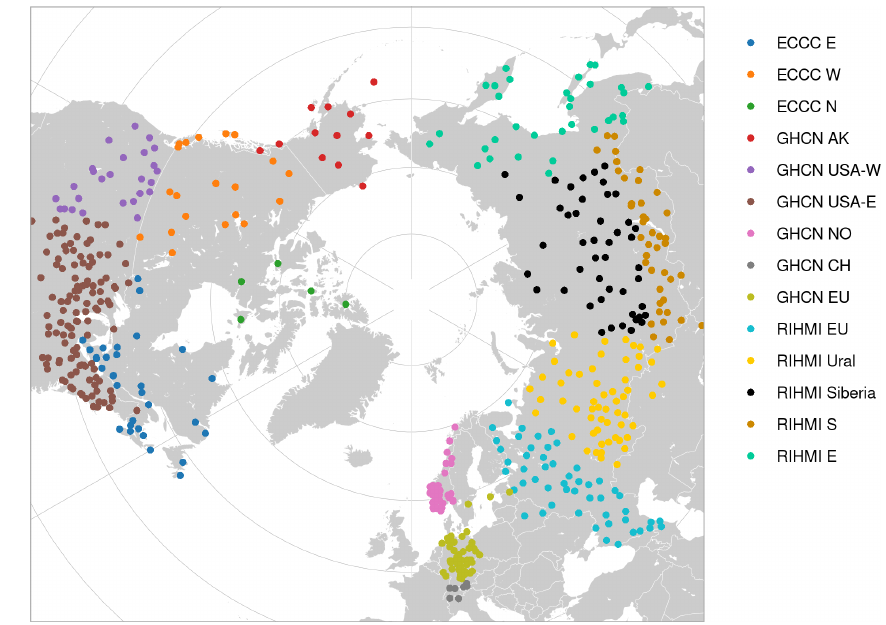
Figure 1. Spatial distribution of the stations used in the